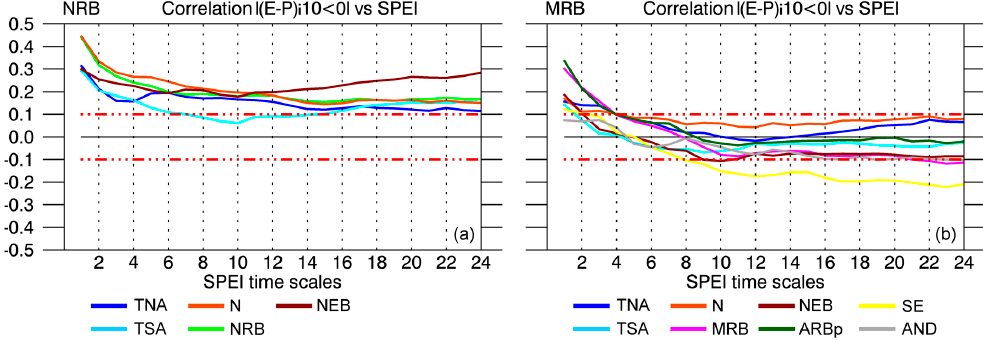
Figure 10. Monthly correlation between | (E − P)i10 < 0| with SPEI1–24 temporal scales over the NRB ( a ) and MRB ( b ). Period: 1980–2016.